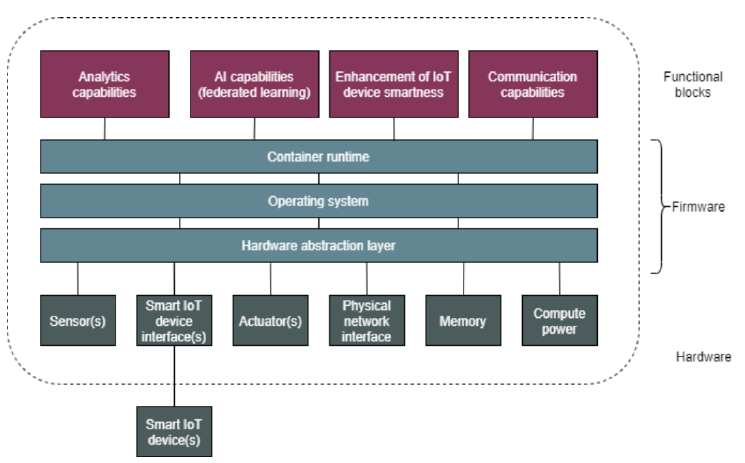
Figure 4. ASSIST-IoT node view.